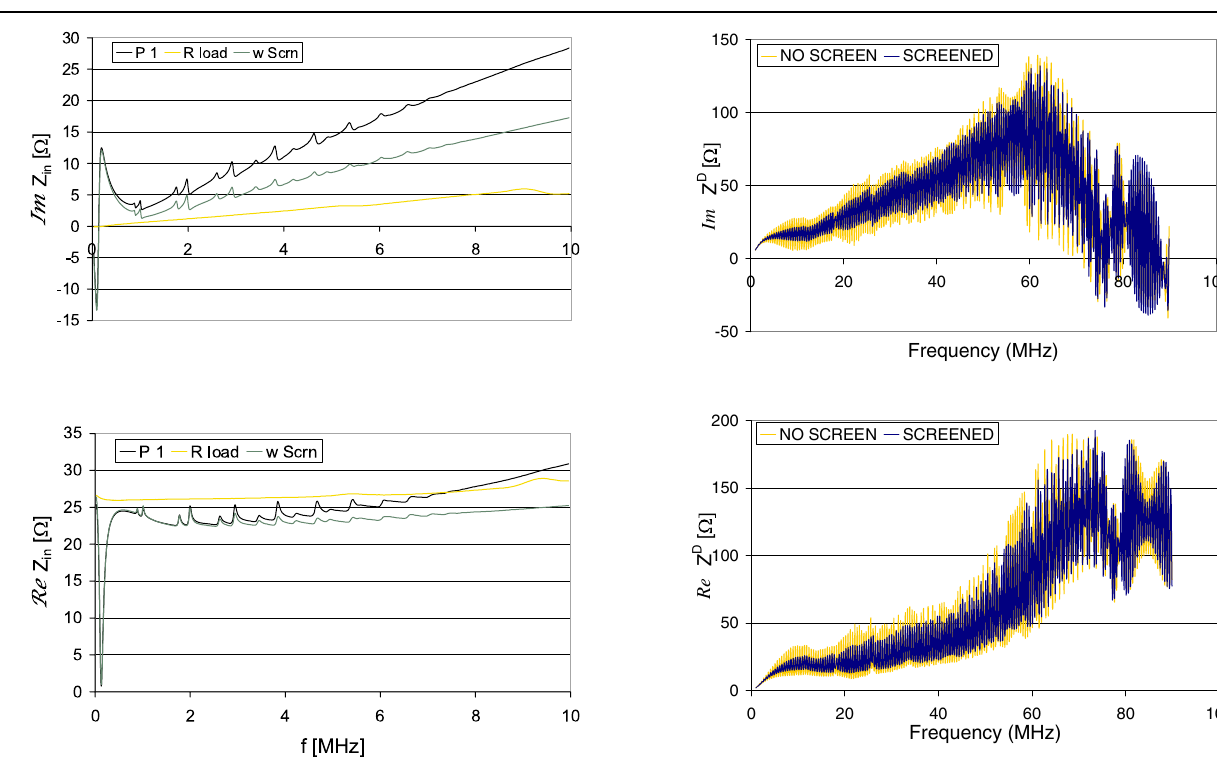
PFN.FIG. 16. (Color) Input impedance of the